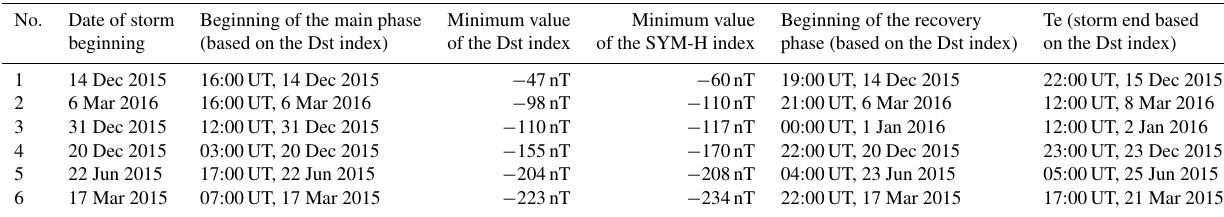
Table 1. Characteristics of the geomagnetic storms used in the